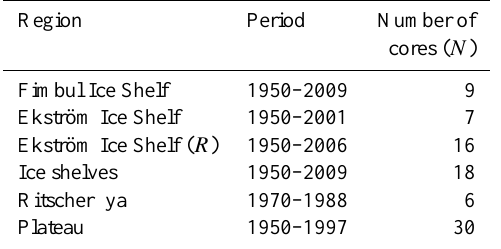
Table 1. Time periods and number of contributing cores for the composite records for western DML. “Ice shelves” corresponds to all cores from the Fimbul, Ekström and Riiser-Larsen ice shelves. “Ekström ( R )” refers to all cores from the Ekström Ice Shelf plus the adjacent ridges Søråsen and